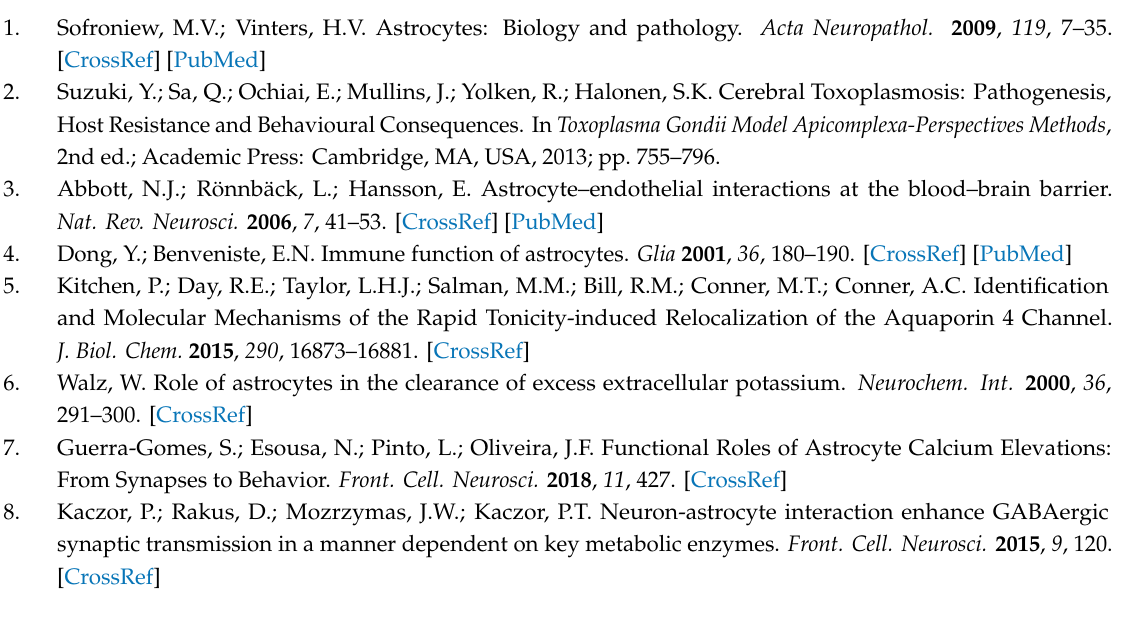
Figure S1: Treatment of 5000 astrocytes / well with no dopamine added (control). Figure S2: Treatment of 5000 astrocytes / well with 25 µ M dopamine. Figure S3: Treatment of 5000 astrocytes / well with 50 µ M dopamine. Figure S4: Treatment of 5000 astrocytes / well with 75 µ M dopamine. Figure S5: Treatment of 5000 astrocytes / well with 100 µ M dopamine. Figure S6: Treatment of 5000 astrocytes / well with 125 µ M dopamine. Figure S7: DAPI stained astrocytes (untreated control). Figure S8: DAPI stained astrocytes (treated with 25 µ M dopamine). Figure S9: DAPI stained astrocytes (treated with 50 µ M dopamine). Figure S10: DAPI stained astrocytes (treated with 75 µ M dopamine). Figure S11: DAPI stained astrocytes (treated with 100 µ M dopamine). Figure S12: DAPI stained astrocytes (treated with 125 µ M